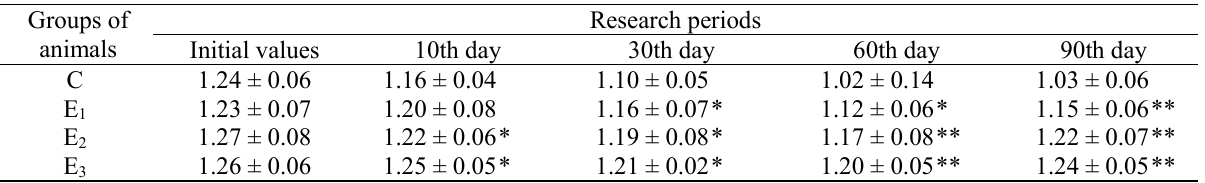
The effect of methionine, phenarone and methyphene on the serum activity of catalase in piglets under chronic nitrate-nitrite toxi cosis, nmoles/min for 1 mg of protein (М ± m, n =